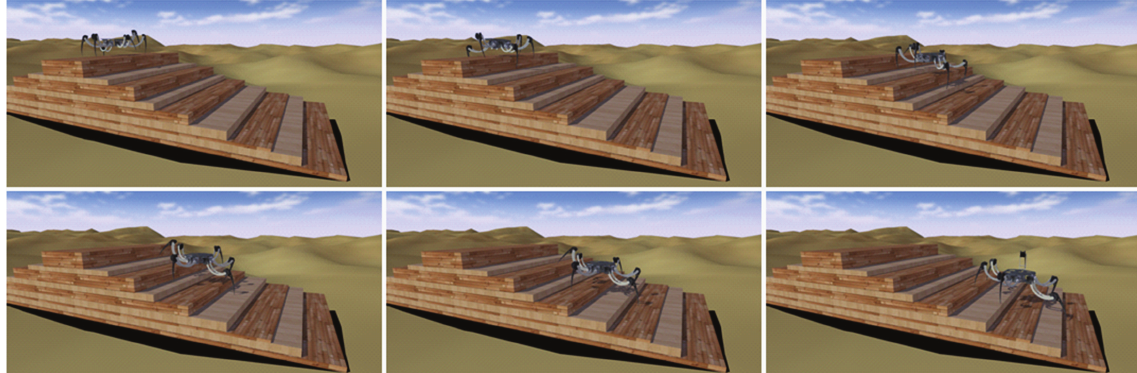
Figure 7: Pictorial representation of robot descending steps of variable depths using Foothold Reflex Control (FRC) method.